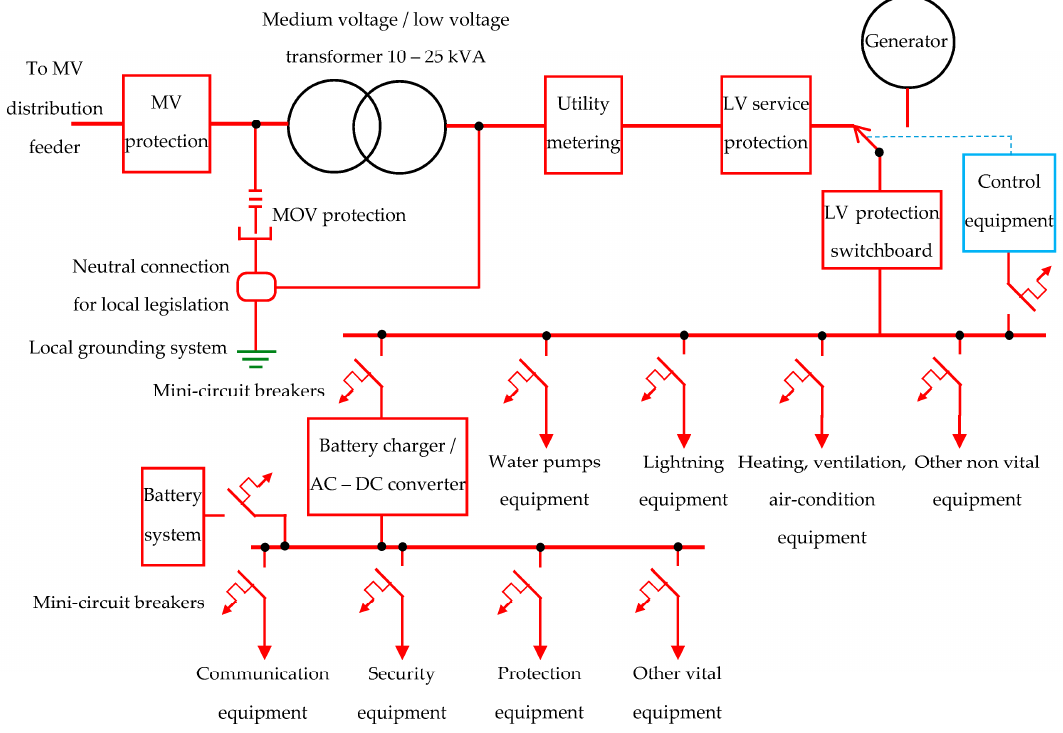
Figure 2. Typical single line diagram of the auxiliary power IT (isolated or impedance-earthed neutral) system supplied by the medium voltage distribution system according to International Council on Large Electric Systems (CIGRE; [45], similar to Figure 7.1).